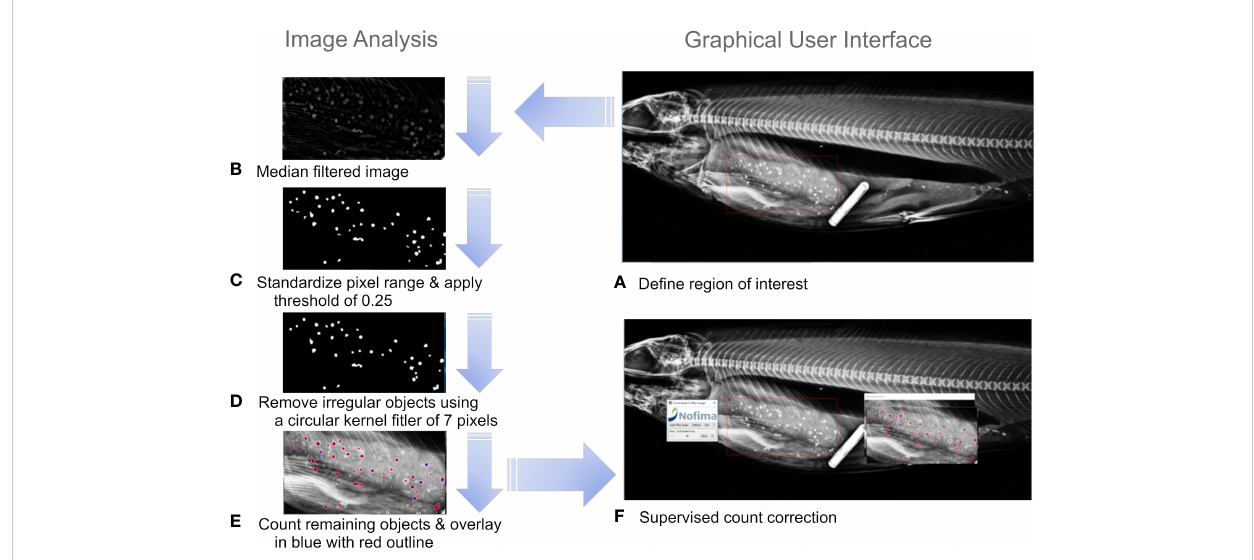
FIGURE 2 Schematic of image analysis steps used in bead counting (A) de fi ne the region of interest, (B) Median fi ltered image, (C) Standardized pixel range from 0 to 1 and apply a threshold of 0.25, (D) Remove irregular objects using a circular kernel of 7 pixels. (E) Count remaining objects and overlay counted objects on the original image in blue with red outline, (F) supervised bead count